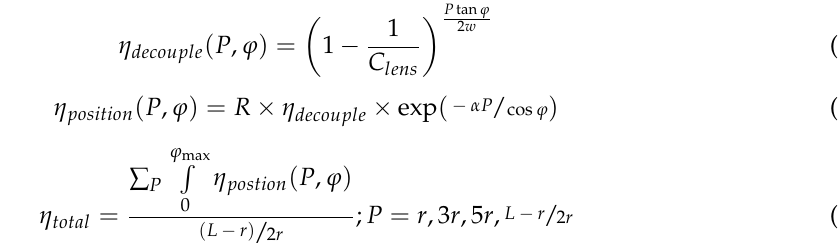
Figure 5. ( a ) A planar waveguide with mirror-coated prisms placed on the top of the lens array. A prism is exaggerated for convenient interpretation and ray-tracing analysis is applied to illustrate how the sunlight decouples inside the waveguide; ( b ) Ray tracing on a planar waveguide combined with a mirror-coated spherical lens array to illustrate planar waveguide collects light from different lenses and transports it to the exit port.